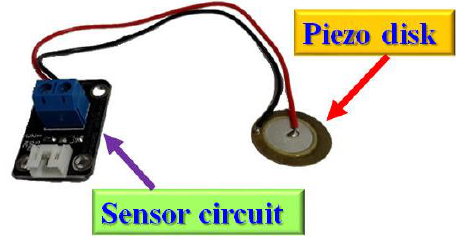
Figure 15. Analog piezo-disk vibration sensor.